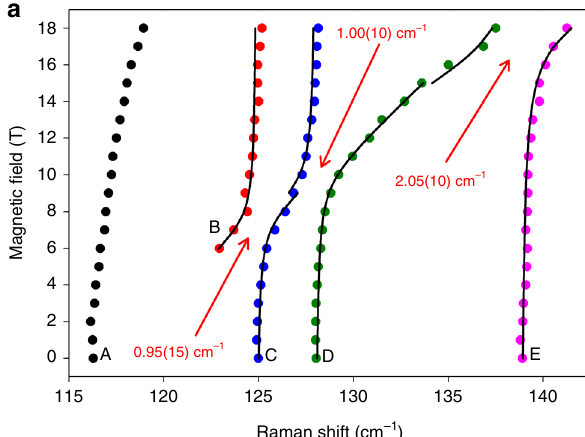
Fig. 4 Peak positions vs. magnetic fi elds for selected transitions in the Raman spectra. a 1 ; b 1- d 4 ; c 1- d 18 . The solid lines are fi ttings using Eq. (2), giving the coupling constants | Λ |. Arrows point to corresponding avoided crossings for | Λ |